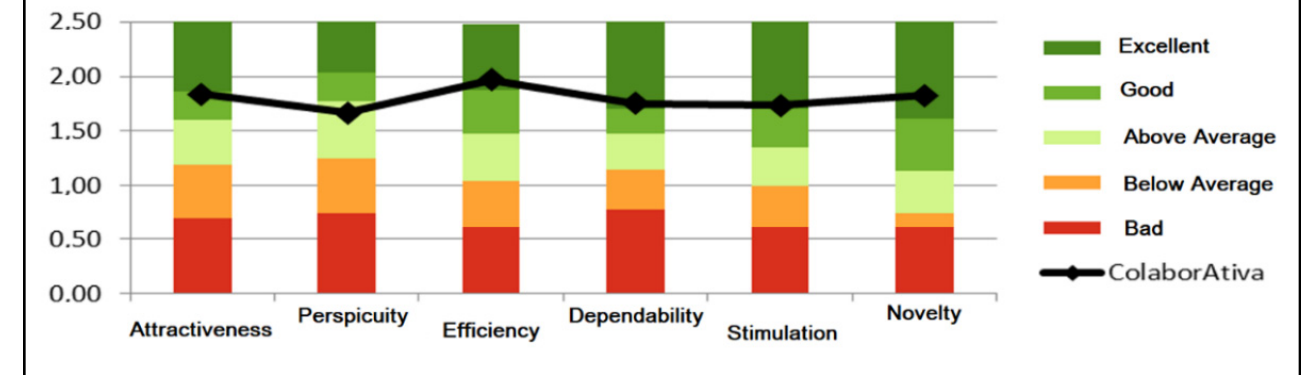
Figure 5. Benchmark graphic generated by data analysis tool provided by UEQ [28].